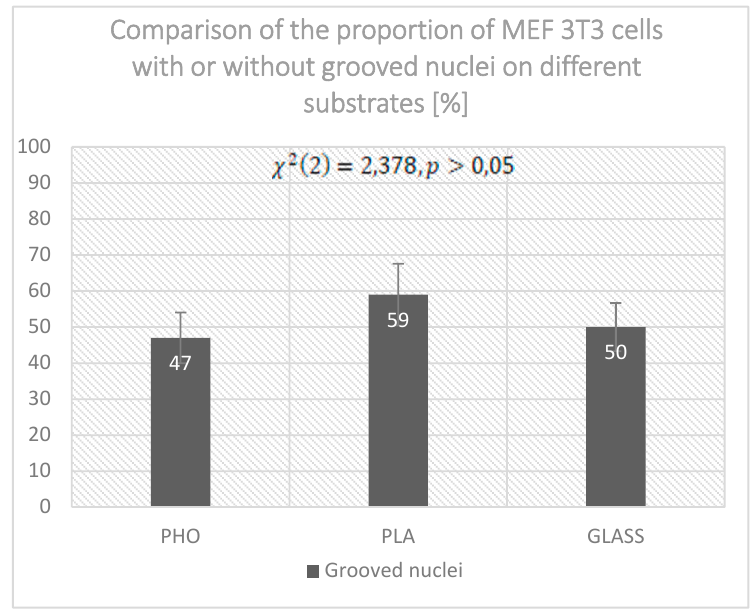
Figure 4. Comparison of the amount of the cells with or without grooved nuclei for cultures grown on PHO, PLA, and glass.